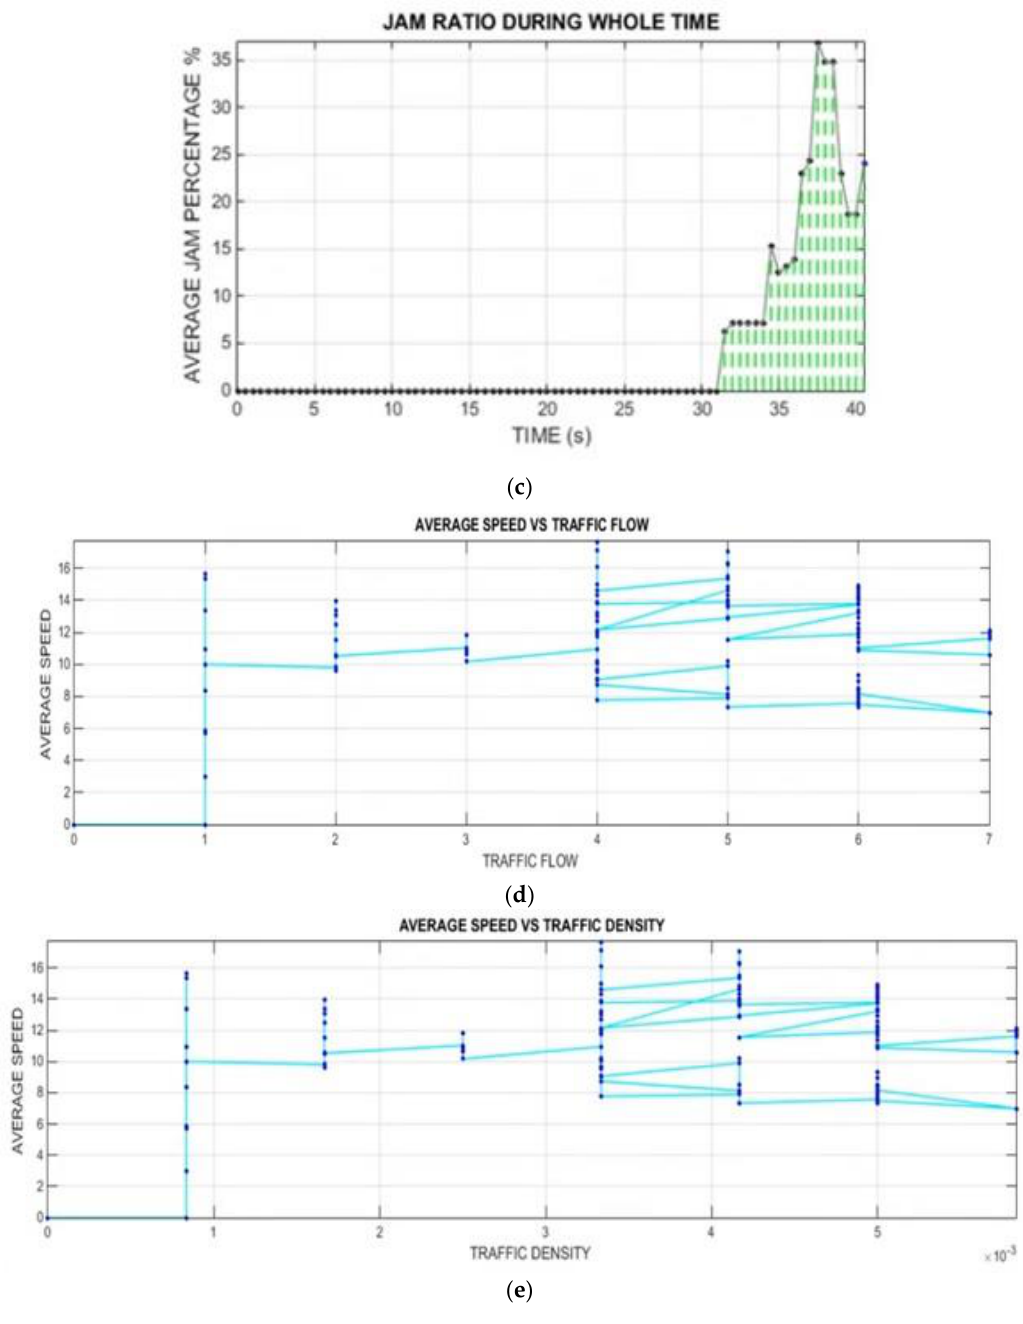
Figure 14. Scenario 3: Hybrid simulation (LAVs and no-LAVs) vehicles results. ( a ) Traffic conges- tion; ( b ) space utilization; ( c ) traffic jam ratio; ( d ) average speed vs. traffic flow results; ( e ) average speed vs. traffic density results.